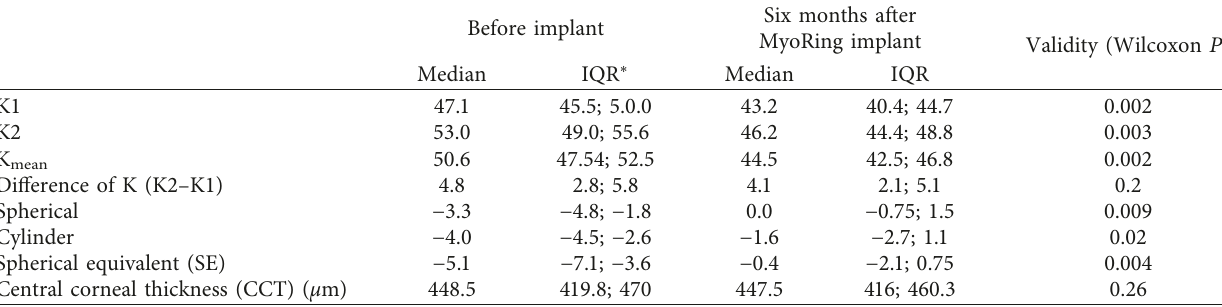
Table 1: Corneal parameters and refractive status before and 6months after MyoRing implantation in eyes with keratoconus. Before